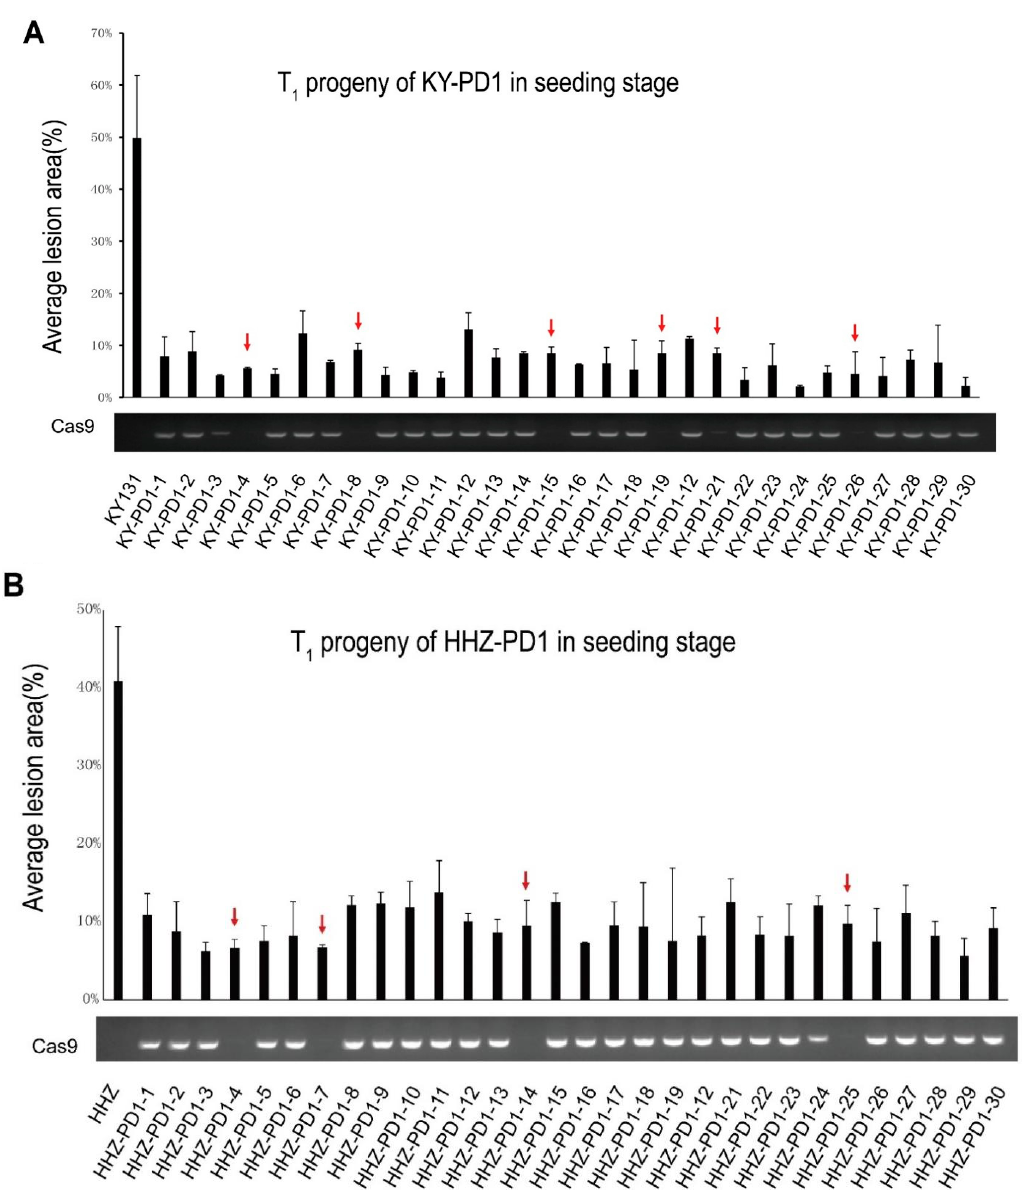
Figure 4. Disease resistance and genotype identification test in T 1 progeny of KY-PD1 and HHZ-PD1. ( A ) Average lesion area of each T 1 plant was measured 14 days after PXO99 inoculation to evaluate disease resistance. Compared with KY131-WT, all T 1 progeny of KY-PD1 showed good disease resistance to PXO99. Results of PCR by primers PCas9-F/R showed that 6 of the 30 T 1 plants failed to detect the Cas9 sequence. ( B ) Average lesion area of each T 1 plant was measured 14 days after PXO99 inoculation to evaluate disease resistance. Compared with HHZ-WT, all T 1 progeny of HHZ-PD1 showed good disease resistance to PXO99. Results of PCR by primers PCas9-F/R showed that 4 of the 30 T 1 plants failed to detect the Cas9 sequence. The red arrow indicates transgene-free T 1 plants without exogenous Cas9-introduced fragment. Family and Identification of the Bacterial Growth Curve KY-PD1 and HHZ-PD1 samples with/without exogenous DNA were used to map the bacterial growth curve after PXO99 infection. The results showed that the T 2 generation plants (with/without exogenous DNA) of both PXO99 inoculated KY-PD1 and HHZ-PD1 showed lower growth rates and total bacterial counts compared to the wild type. This indicated that bacterial growth was inhibited in the KY-PD1 and HHZ-PD1 families after PXO99 inoculation due to the deletion of the bacterial-inducible element (Figure 5). Important agronomic traits of the T 2 generation plants belonging to the KY-PD1 and HHZ-PD1 families were examined (Tables 4 and 5). T 2 generation KY-PD1 and HHZ-PD1 plants with/without exogenous DNA showed no statistical differences compared to the wild type in heading stage, plant height, panicles per plant, panicle length, or seed setting rate. This proved that the successful deletion of the bacterial-blight-inducible element in the Xa13 gene promoter did not affect rice agronomic traits except for disease resistance. Promoter editing vector was successfully used in the present study to improve bacterial blight resistance in two conventionally cultivated rice varieties, KY131 ( Geng ) and HHZ ( Xian ). This method of editing the promoter region can be used universally and has great application potential in breeding disease-resistant rice, especially for conventional rice varieties.